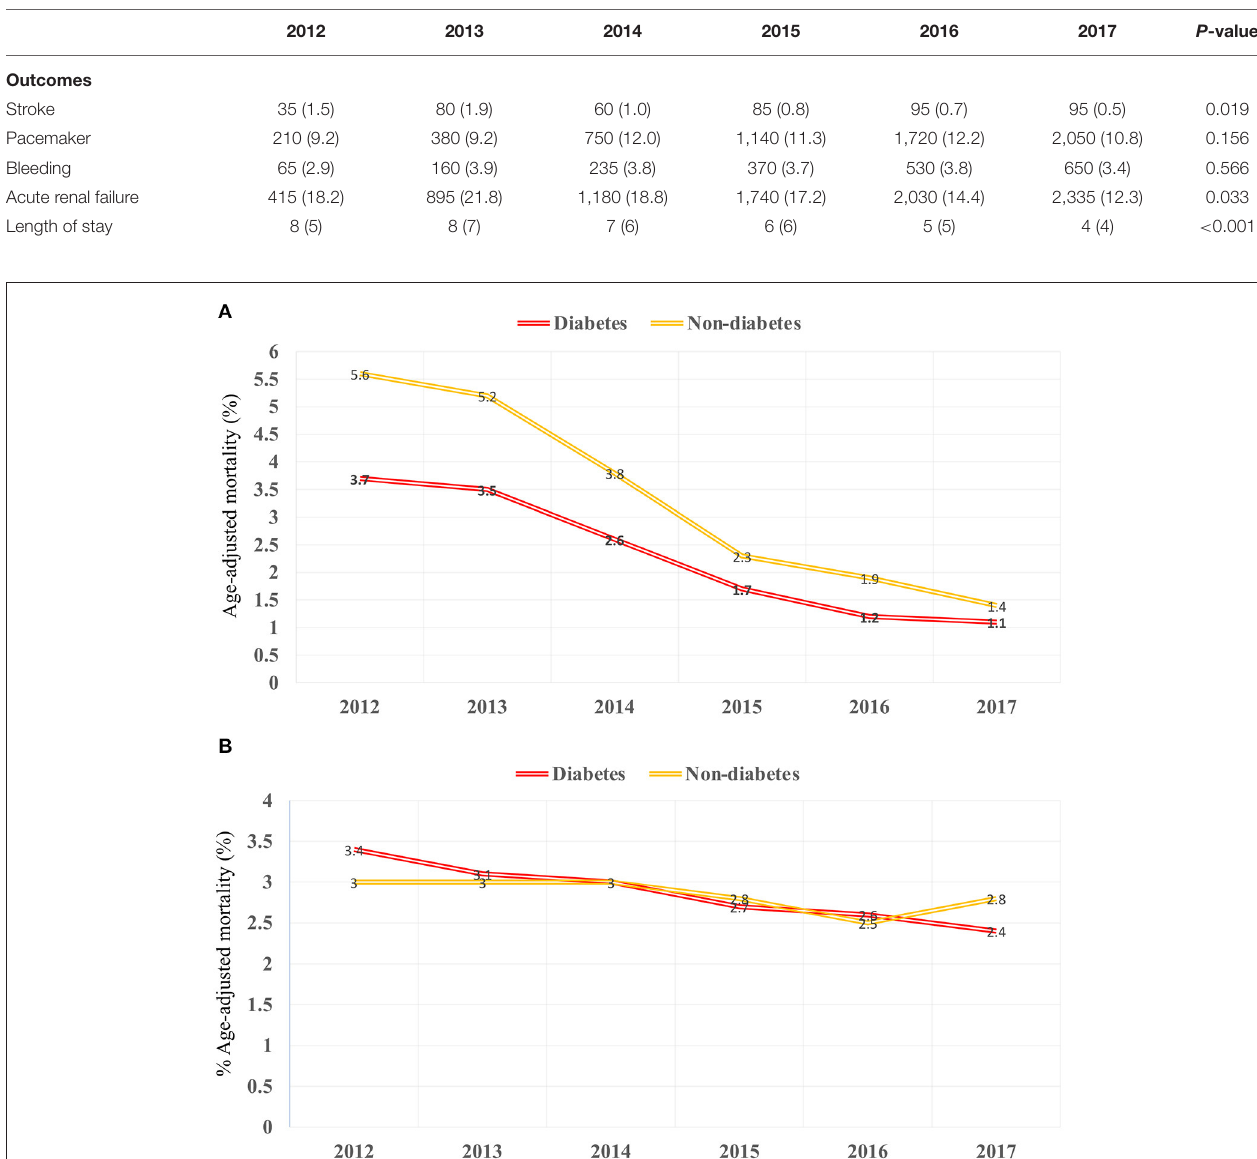
with missing data and weighting ( Figure 1 ); 31.7% of them were hospitalized for TAVR and 68.3% for sAVR. The diabetes population constituted 36.8% of TAVR patients and 26.5% of sAVR